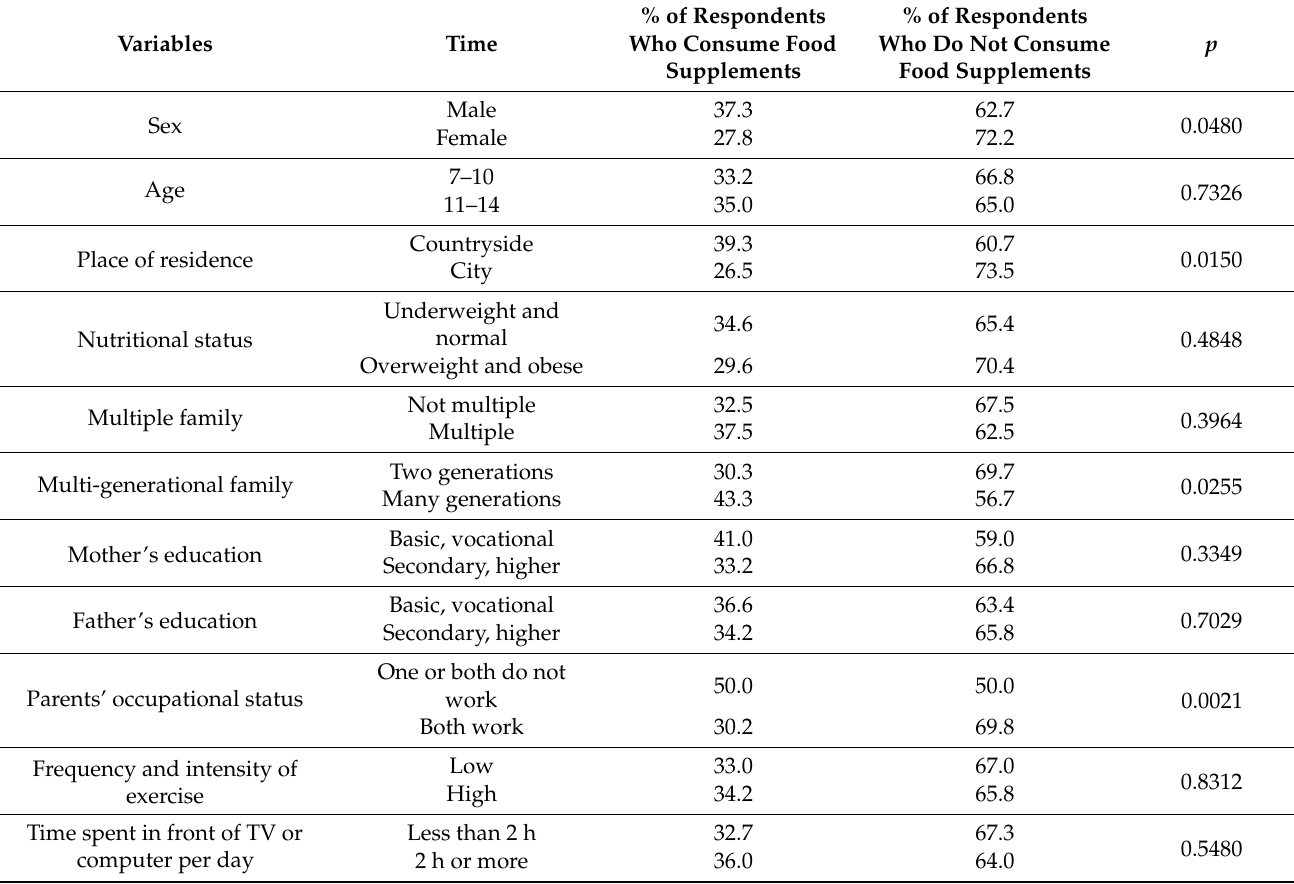
Table 4. Percentage of children with respect to selected factors divided in relation to whether or not they consume dietary